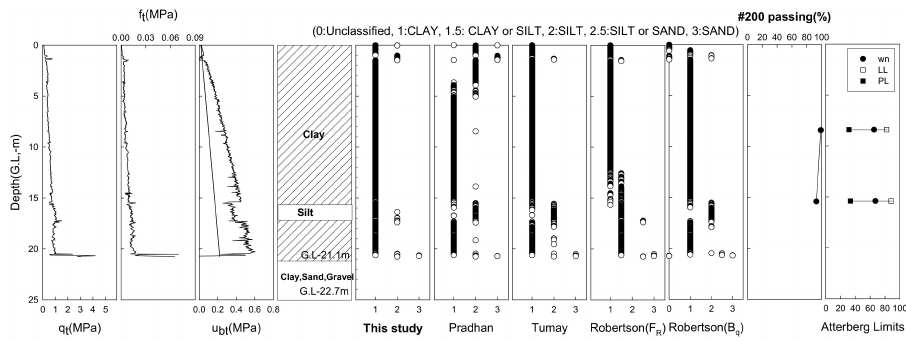
Figure 9. Verification results at Busan new port